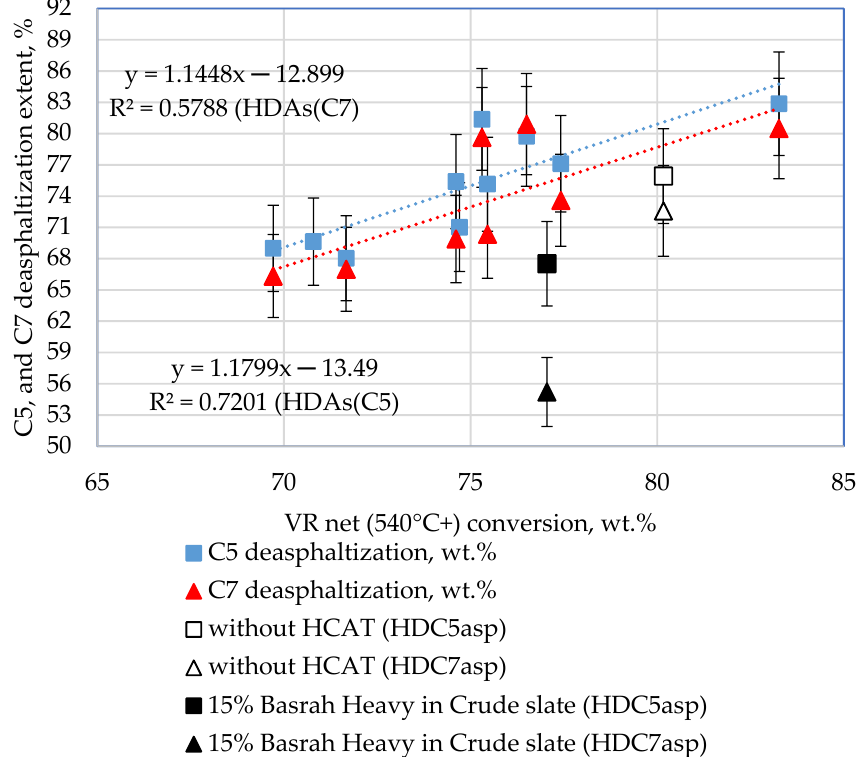
Figure 13. Relation of hydrodeasphaltization to vacuum residue net conversion.